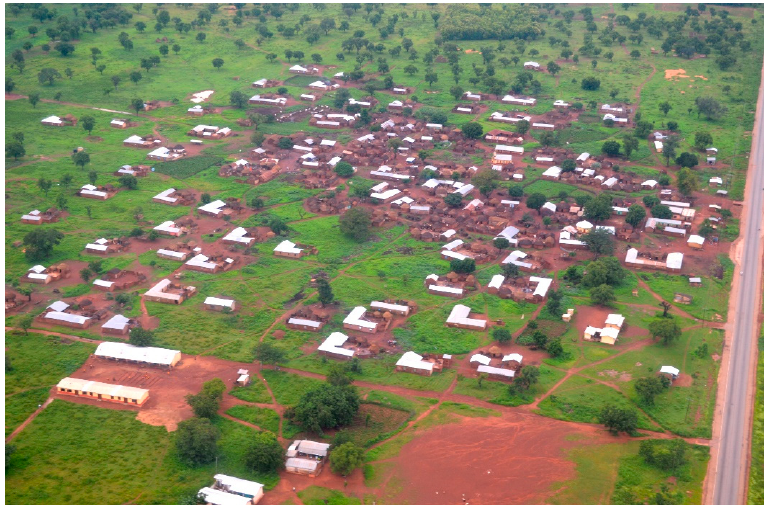
Figure 9. Periurban village located along the major Tamale–Savelugu road in the outer periurban zone 19 km away from Tamale’s city centre (source: Author, 2014).